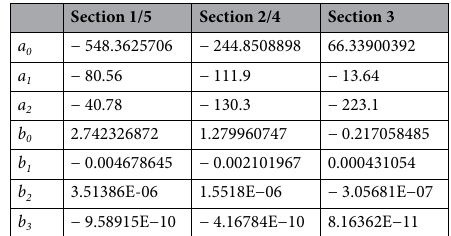
Table 4. Parameter values of the magnetic loss calculation model.